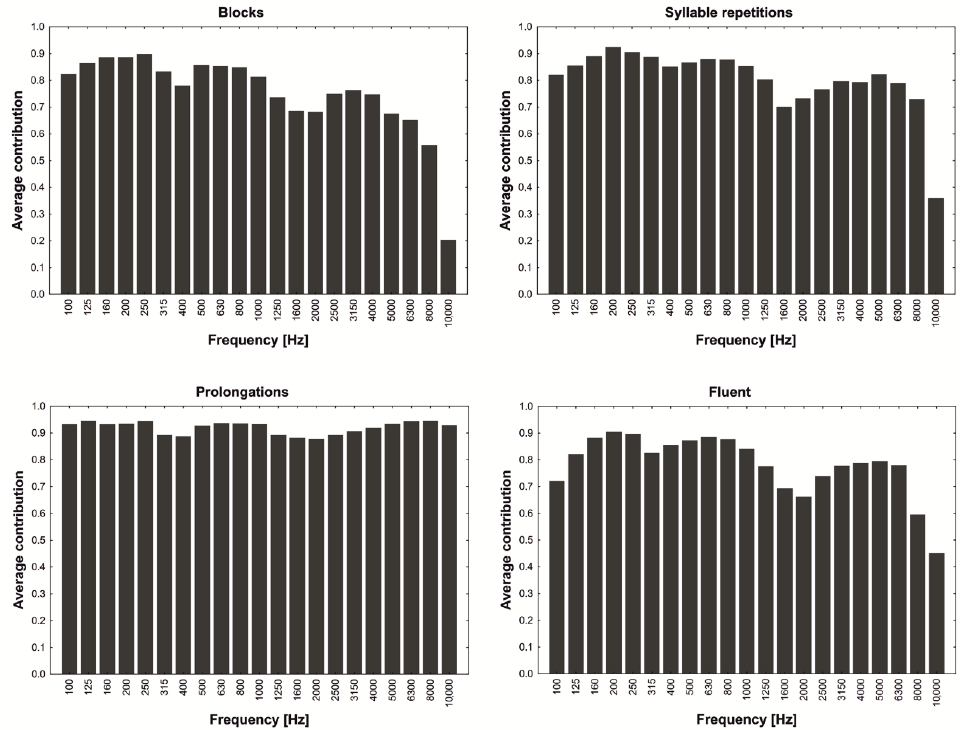
Figure 2. The average contribution of variables to the PCA model according to the analysed utter- ance type.